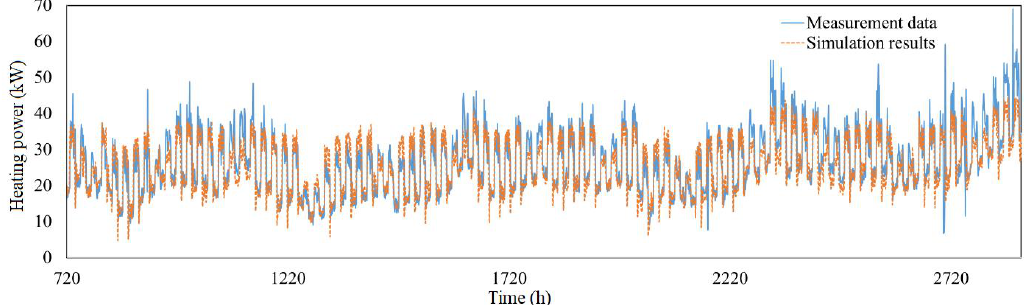
Figure 5. An example of a 3-month comparison between measured and simulated heat consumption, after calibrating the system operation.